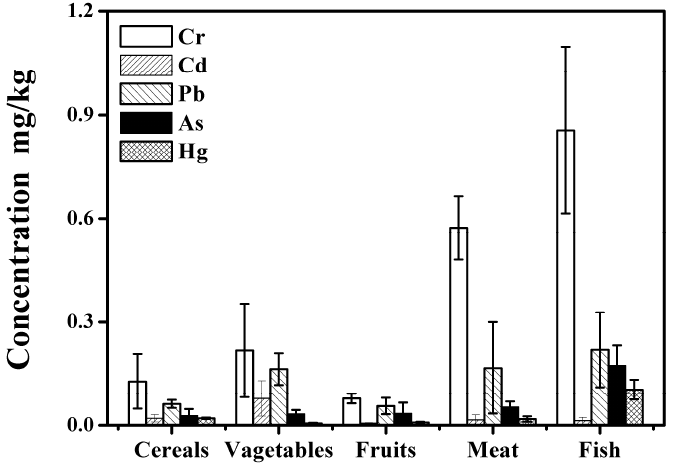
Figure 3 . Heavy metal concentrations in different foodstuff species.